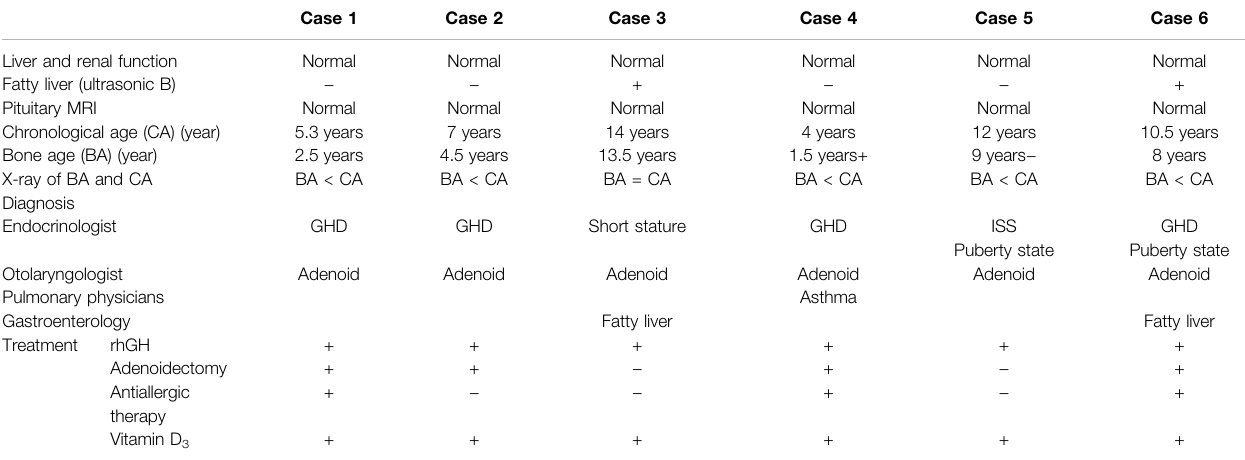
TABLE 1 | ( Continued ) Summary of main clinical features and laboratory results of six cases with SLC22A18-associated